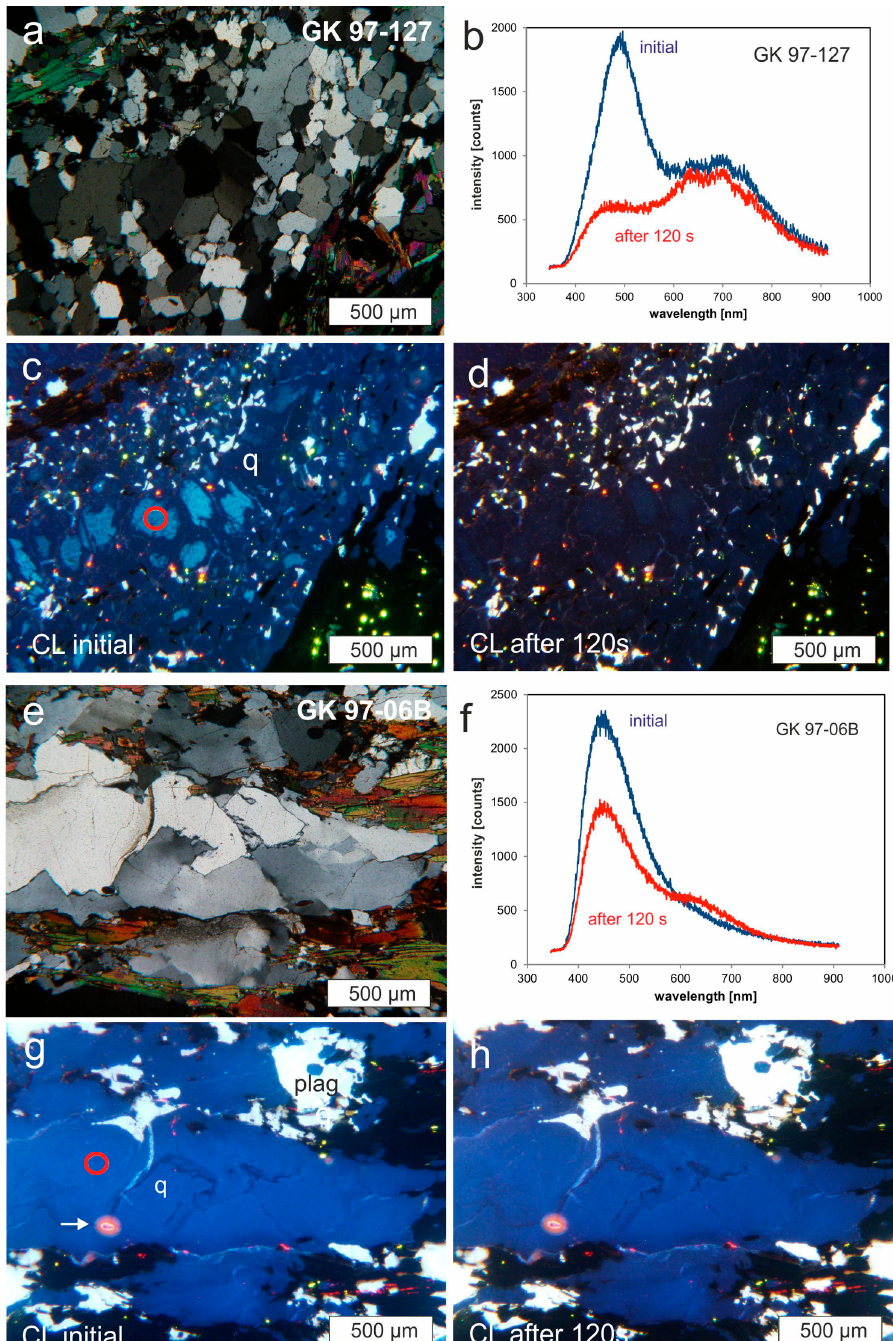
Figure 4. Polarized light and CL micrographs of two metamorphic rocks from the kyanite-sillimanite-muscovite zone (GK 97-127) and the garnet-cordierite-sillimanite-K-feldspar zone (GK 97-06B) showing different luminescence characteristics; ( a ) polarized light micrograph of sample GK 97-127; ( b ) CL emission spectra of quartz in sample GK 97-127 showing a dominant initial emission band at ca. 490 nm and the spectrum after 120 s of electron irradiation; ( c , d ) CL images of sample GK 96-82 initially and after 120 s of electron irradiation; the short-lived blue-green CL of quartz disappeared; ( e ) micrograph in polarized light of a quartz-rich area in sample GK 97-06B; ( f ) CL emission spectra of quartz in sample GK 97-06B showing a dominant initial emission band at ca. 450 nm and the spectrum after120 s of electron irradiation ( g , h ) CL images of sample GK 97-06B showing blue CL of quartz (q) and radiation halos around micro-inclusions (arrow); the circle marks the spot for CL spectroscopy.